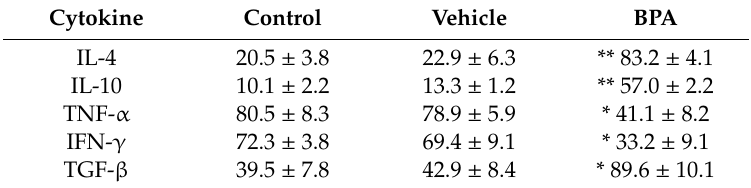
Table 2. Cytokine pattern in testicular tumours of control, vehicle and BPA-treated